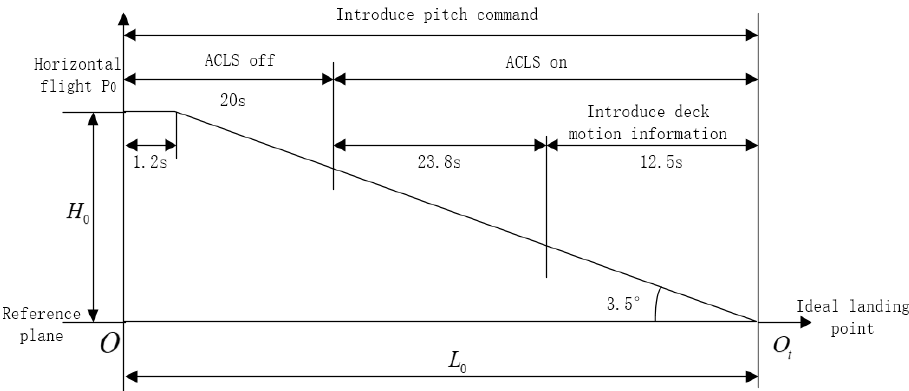
A C L S during the gliding stage of carrier-based air- L ong